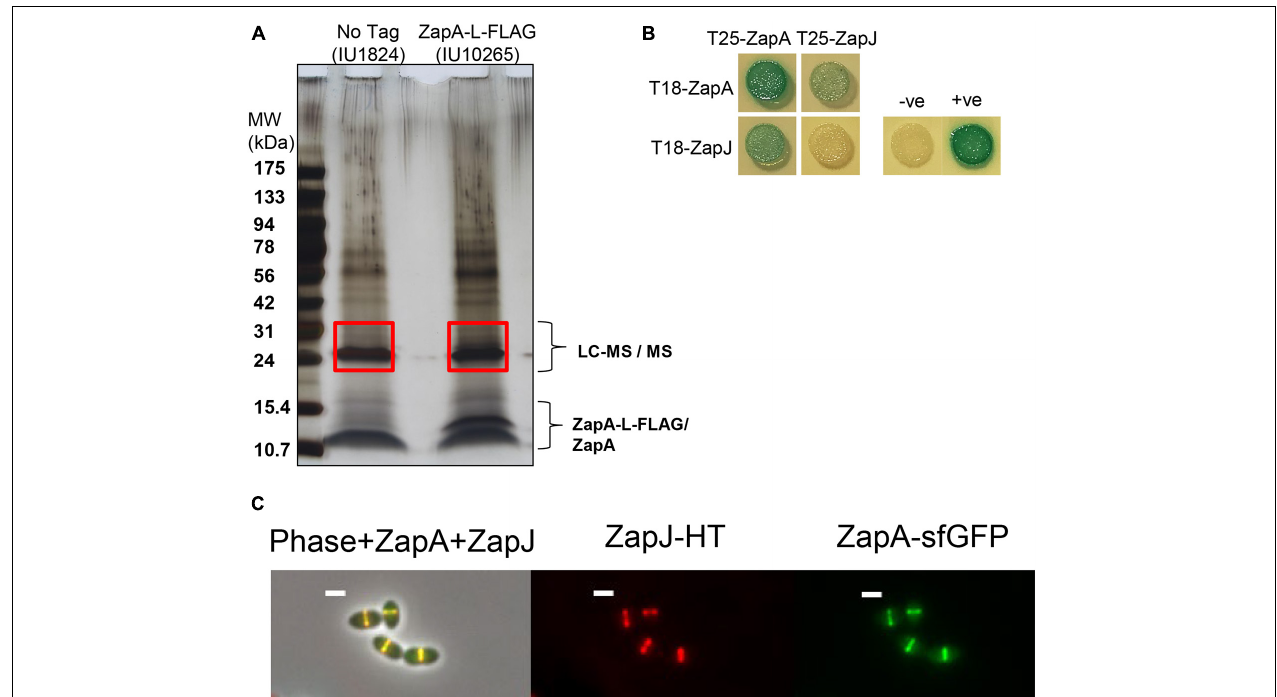
FIGURE 11 | ZapA can co-IP ZapJ (Spd_1350) and these proteins co-localize at midcell rings. Cells were cultured in BHI broth and harvested at OD 620 ≈ 0.1-0.25 for experiments. (A) Silver-stained SDS-PAGE gel from Co-IP experiments performed using WT (IU1824, lane 1 non-flagged control) and ZapA-FLAG (IU10265, lane 2) as bait. Red boxes indicate excised bands that were processed for LC-MS/MS (see section “Materials and Methods”). PAGE ruler pre-stained ladder and calibrated MW shown on the left. (B) ZapA and ZapJ from Spn interact directly, and ZapA self-interacts by B2H assays. T25 or T18 fusions are expressed from low-or high-copy plasmids, respectively. Plasmid pairs pKT25/pUT18C and pKT25- zip /pUT18C- zip were used as negative (–ve) and positive (+ve) controls. B2H assays were performed as described in Materials and Methods . Agar plates were photographed after 40 h at 30 ◦ C. B2H assays were performed at least twice with similar results. (C) Co-localization of ZapJ-HT and ZapA-sfGFP in the same cells of strain IU15116. Cells were labeled with 500 nM HT-TMR ligand and imaged using conventional microscopy as described previously (Perez et al., 2019). Representative images are